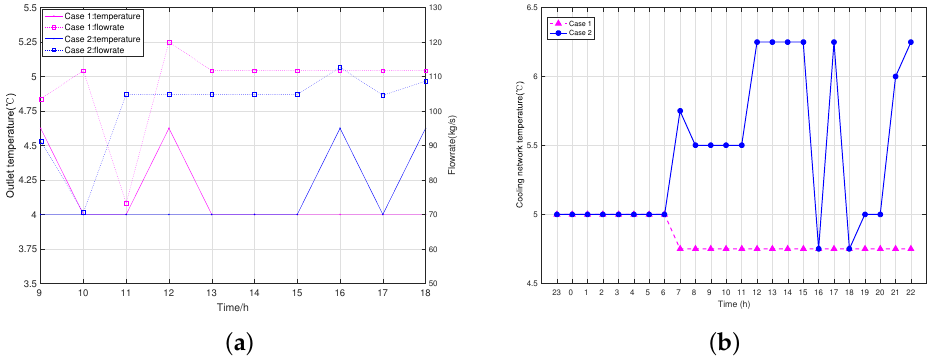
Figure 15. The operation result of AC from the perspective of flowrate and temperature analysis. ( a ) the temperature and flowrate results of AC; ( b ) the mixed temperature in the cold